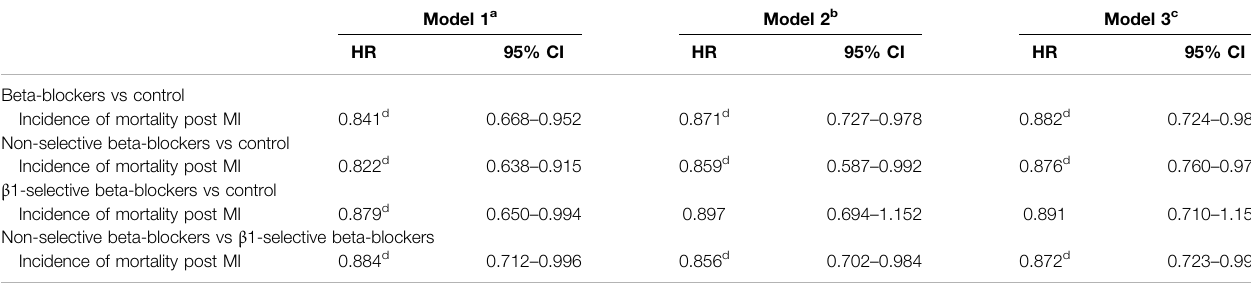
TABLE 3 | Hazard ratios (95% CI) of incident mortality in patients taking beta-blockers, with no beta-blocker treatment as the reference